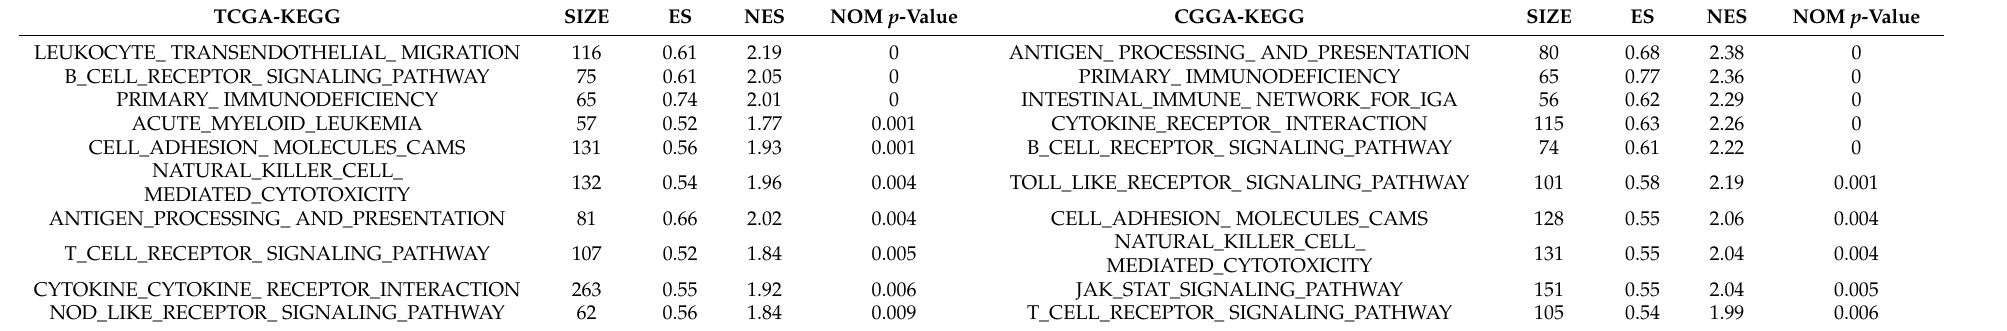
Table 2. Genet set enrichment analysis (GSEA) in GPSM3 high-expression